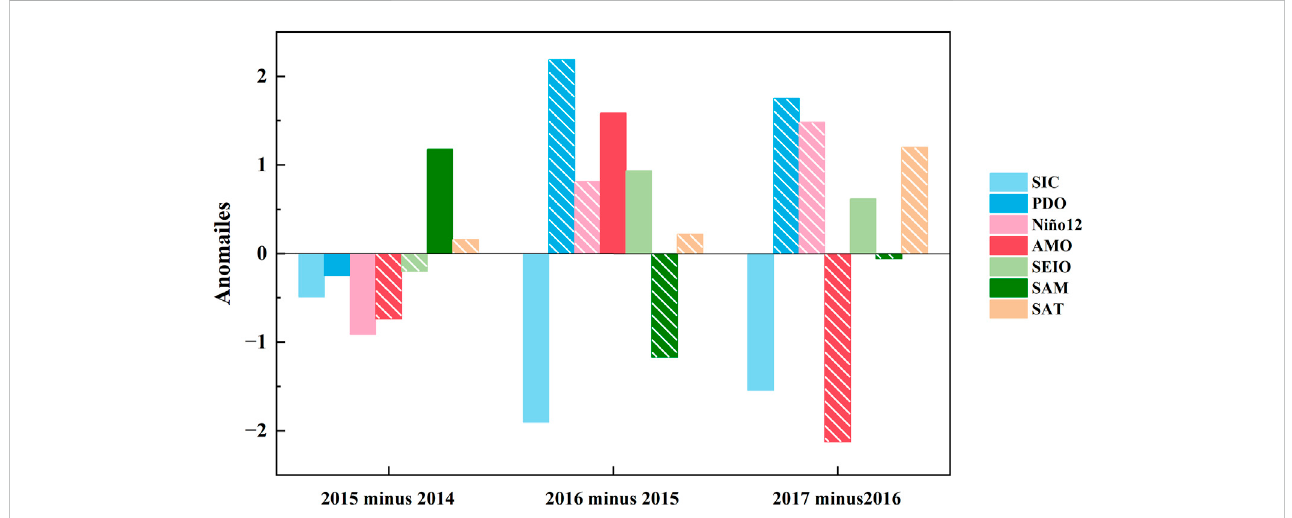
FIGURE 9 ChangesofWeddellSeaSICinaustralsummerandthepredictorsatcorrespondingleadtimeof2015 – 2017comparedwiththeirvaluesovertheprevious year.Forexample,thesymbol “ 2015minus2014 ” ofSICindicatesthedifferenceofWeddellSeaSICbetween2015and2014.Thesymbol “ 2015minus2014 ” of AMO indicates the difference of the AMO index at the season leading 11 seasons of 2015 summer and that of 2014. White diagonal markers indicate positive